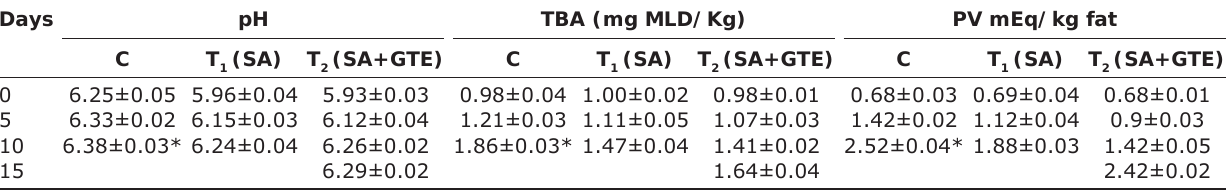
Table-1: pH, TBA, and PV (mean±SE) values of chicken meat nuggets as influenced by different coatings during refrigerated (4±1°C) storage.